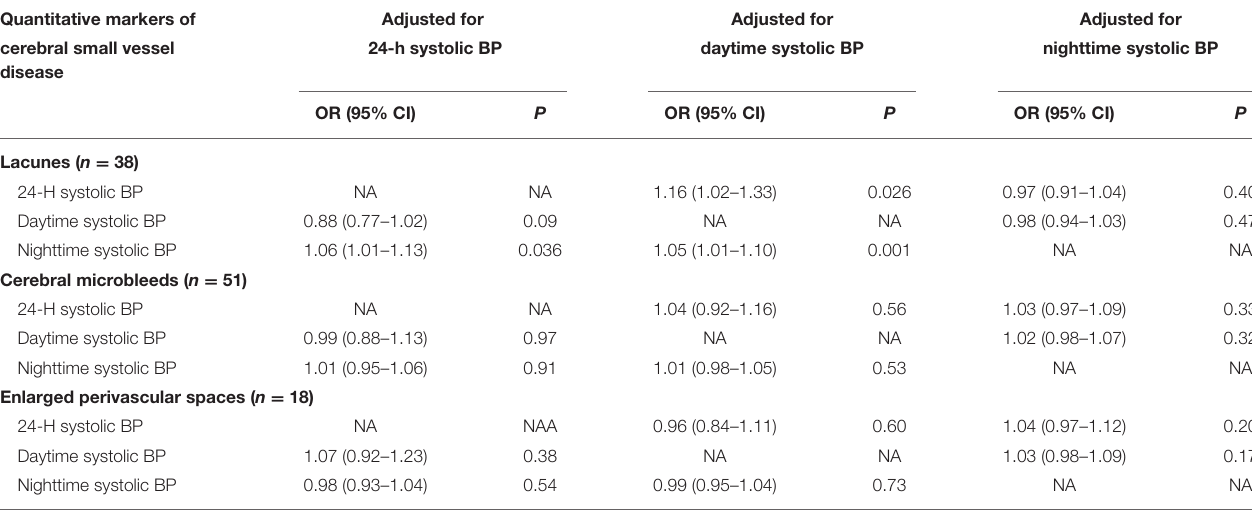
TABLE 3 | Association between categorical subclinical markers of cerebral small vessel disease and ambulatory systolic blood pressure measurements. Quantitative markers of Adjusted for Adjusted for Adjusted for cerebral small vessel 24-h systolic BP daytime systolic BP nighttime systolic BP disease OR (95% CI)